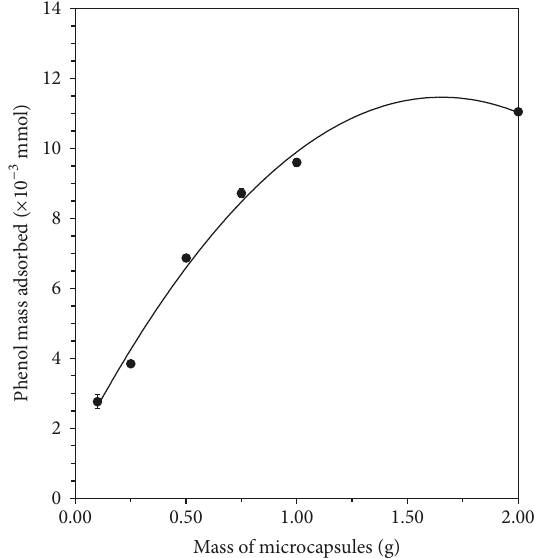
Figure 4: Effect of mass of CA-MC-Cy on the phenol extraction from aqueous solutions. Conditions: 50mL of phenol at 25 mgL −1 (pH = 3 ), 7 hours of experimental